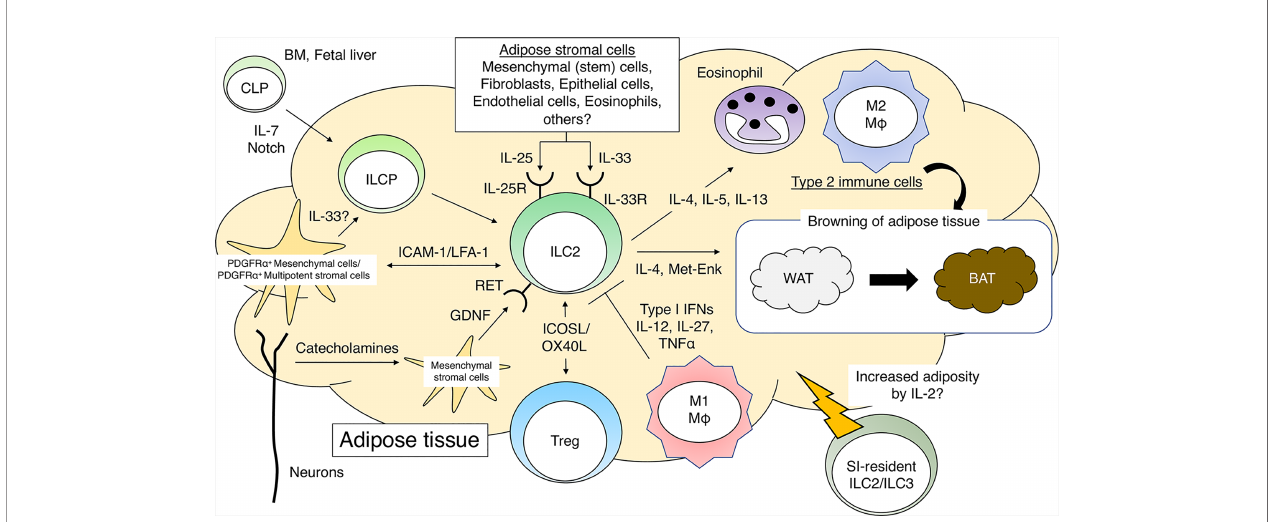
FIGURE 1 | Group 2 innate lymphoid cells (ILC2s) and adipose tissue homeostasis. IL-7 and Notch signaling promote differentiation of common lymphoid progenitors (CLPs) into ILC progenitor cells (ILCPs). PDGFR a + gp38 + mesenchymal cells further promote the differentiation of ILCP into mature ILC2s in adipose tissues. The direct interaction between ILC2s and PDGFR a + multipotent stromal cells is critical for the maintenance of adipose tissue homeostasis. ILC2s, when activated by cytokines such as IL-25 or IL-33, recruit eosinophils and M2 macrophages to sustain a type 2 immune environment in adipose tissues. ILC2s promote WAT browning by producing type 2 cytokines and Met-Enk. ILC2s promote Treg proliferation in adipose tissues in response to IL-33. Neuron-derived catecholamines activate adipose mesenchymal stromal cells to produce GDNF, which stimulates ILC2s and induces a type 2 immune response. During obesity, M1 macrophages produce pro-in fl ammatory cytokines and impair the function of ILC2s in adipose tissues. PDGFR a , platelet-derived growth factor receptor a ; Met-Enk, Met-enkephalin; GDNF, glial-derived neurotrophic